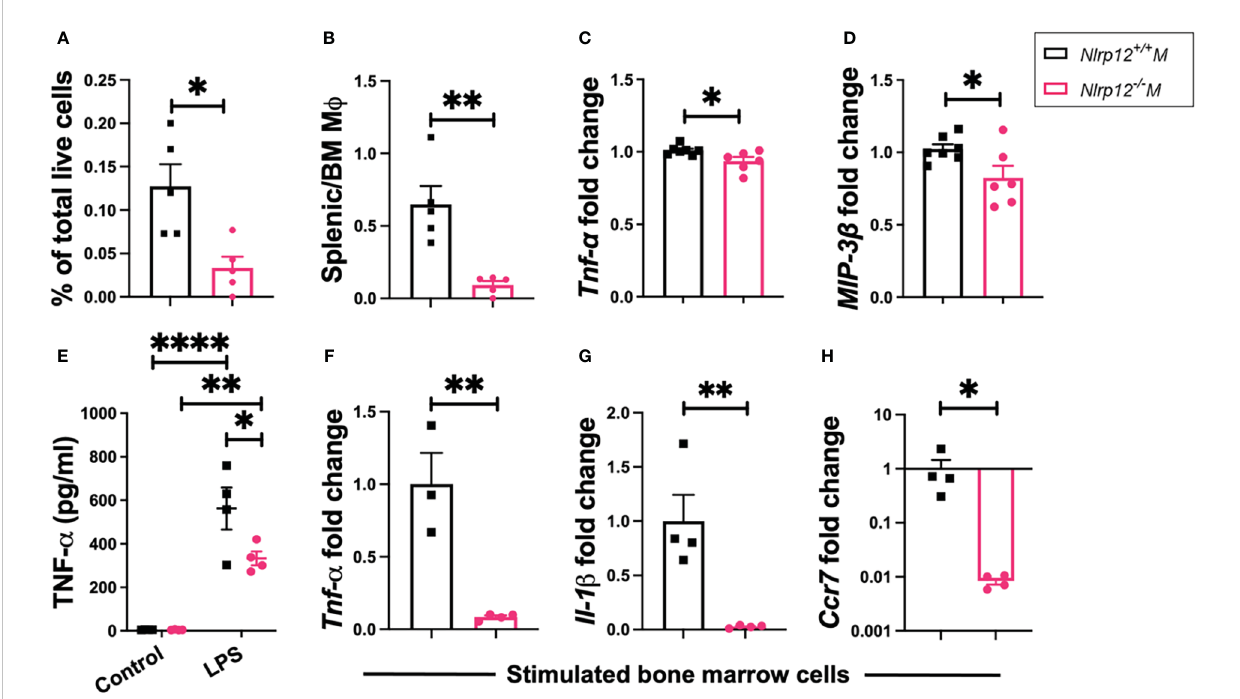
FIGURE 4 Nlrp12 de fi ciency reduces pro-in fl ammatory macrophage responses. Spleens and BM were harvested at the endpoint of 39 weeks of age. (A) The percentage of Gr1 - F4/80 + CD11b + CD11c -/low macrophages in total splenocytes. (B) The ratio of splenic to BM macrophages. (C) Relative transcript level of splenic Tnf. (D) Relative transcript level of splenic Ccl19 /MIP-3 b . (E-H) BM cells were stimulated ex vivo . (E) Level of TNF a in the culture supernatant as determined with ELISA following 4-h stimulation with 1 m g/ml LPS. (F-H) Transcript levels of Tnf (F) , Il1 b (G) and Ccr7 (H) as fold changes over unstimulated controls following 4-h stimulation with 50 ng/ml LPS. Data are shown as mean ± SEM. Signi fi cant differences were determined by Student ’ s t test ( A – D , F – H ) or two-way ANOVA (E) and shown as *P<0.05, **P<0.01, and